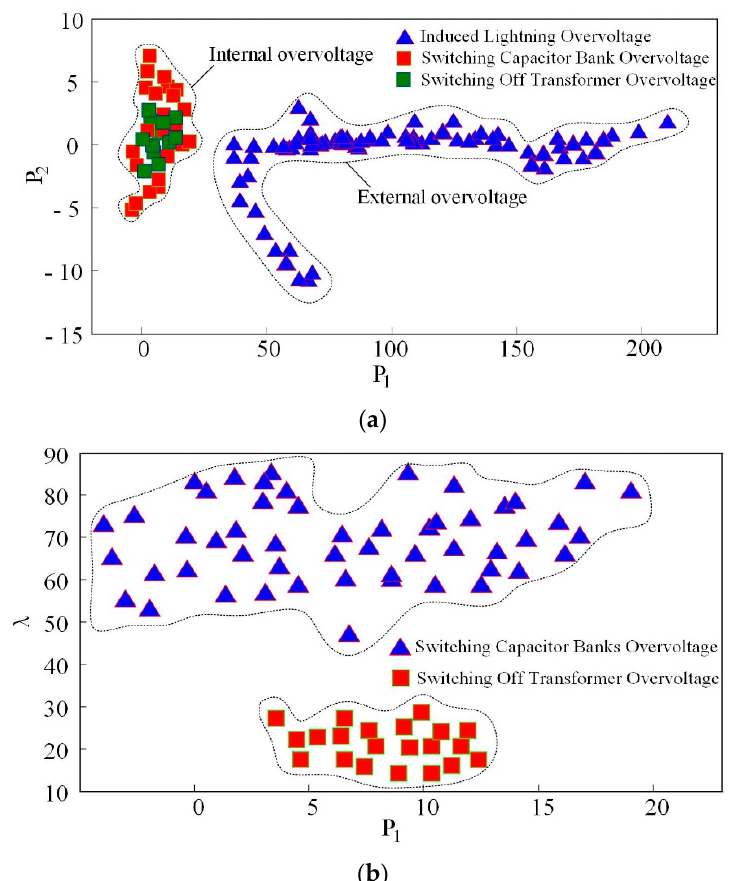
Figure 12. Distribution of overvoltage types. ( a ) Distribution of internal and external overvoltage types in the space of P1–P2; ( b ) Distribution of the two kinds of internal overvoltage in the space of λ –P1.